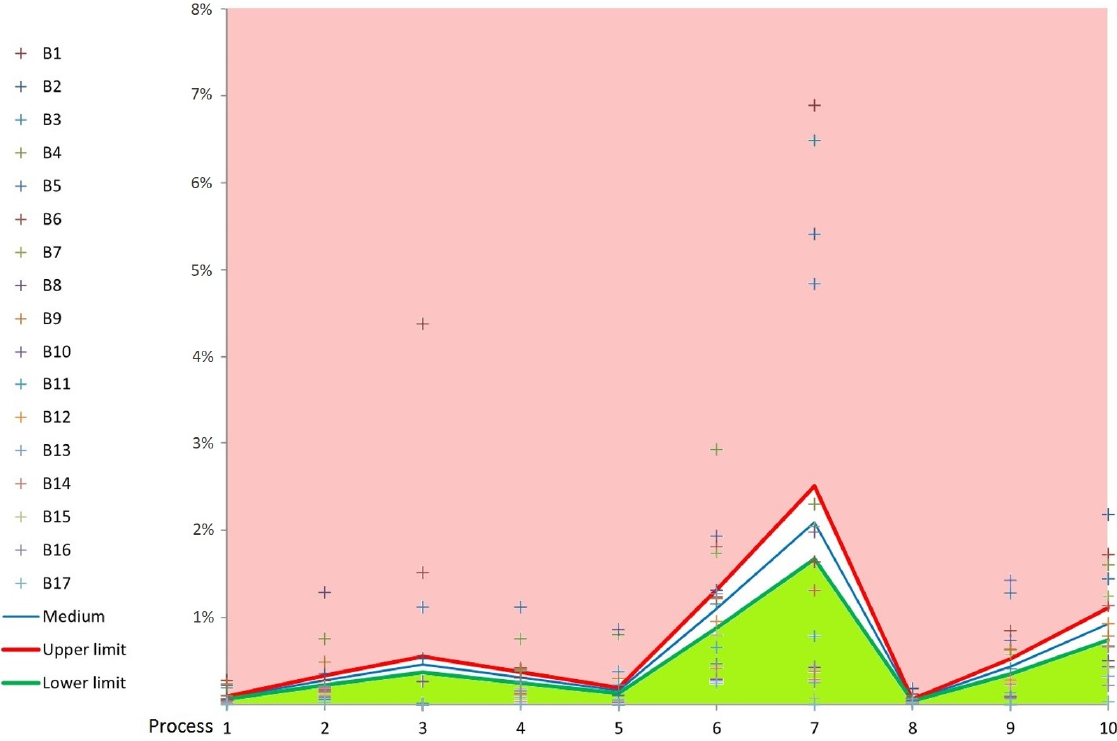
Figure 3. The idea of the assessment method of the correctness of the cost-estimation of mine liquidation processes.